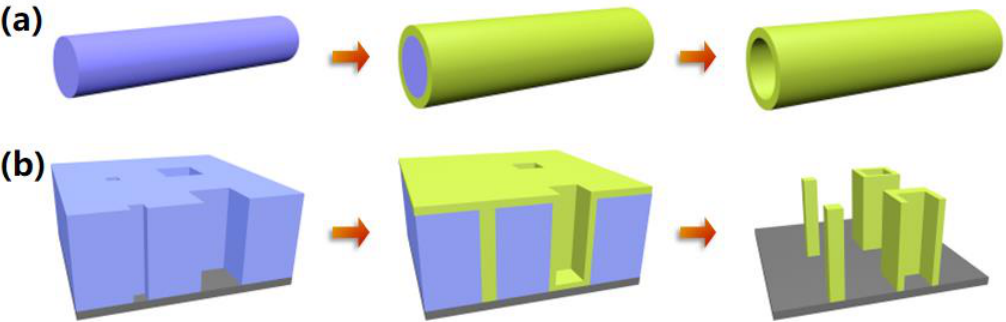
Figure 2. Schematic illustrations of two main fabricating mechanisms for 3D nanostructures based on sacrificial templates by ALA method. ( a ) Mechanism achieving hollow cross-linked 3D nanostructures. ( b ) mechanism achieving arbitrary custom patterns with separated pillars and tubes.